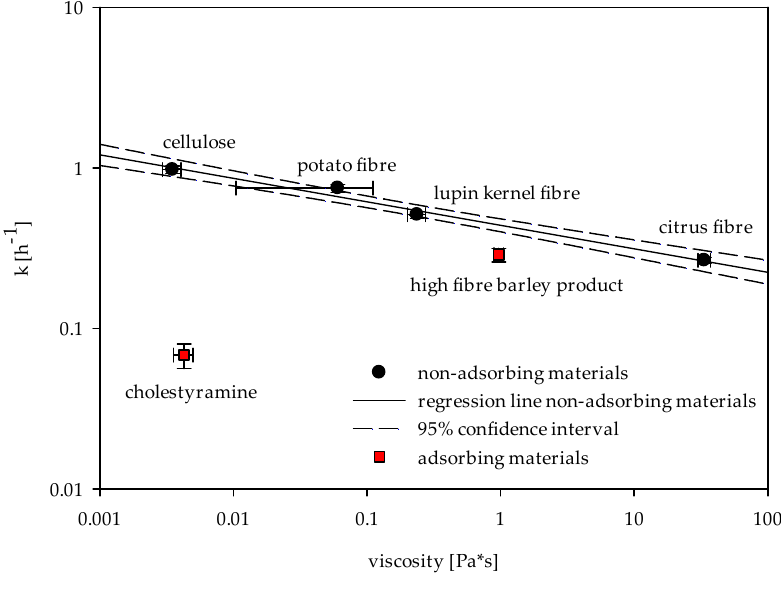
Figure 3. Adsorption of taurocholic acid measured by inverse dialysis model: bile acid concentration as a function of time without (blank) and with different dietary fibre-rich materials and references ( n = 3).